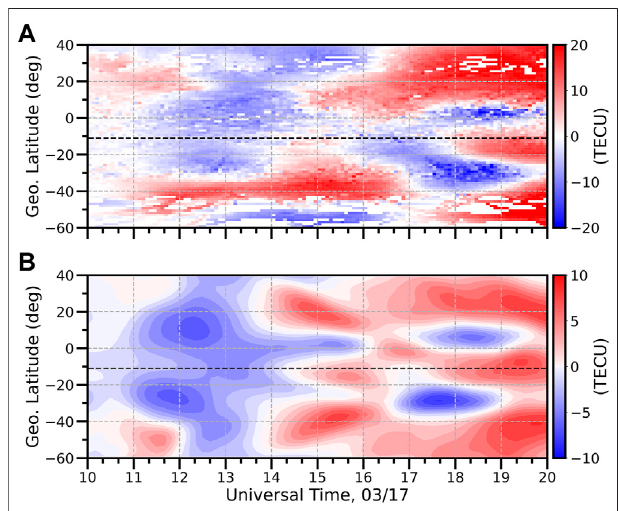
FIGURE 3| Comparison of the storm-quiet differential TEC at 70 ° W as a function of UT and geographic latitude. The black dashed line in each panel corresponds to the geomagnetic equator at 70 ° W. (A) GNSS differential TEC. (B) GITM differential